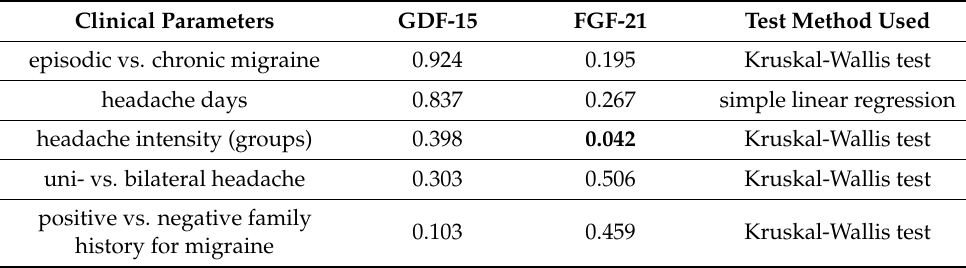
Table 2. Clinical parameters of headache and their impact on GDF-15 and FGF-21 levels. The results are given as p values ( p < 0.05 in bold print). At p values > 0.05, there is no statistically significant association between the respective clinical parameter and the biomarker. Due to different variable types, different statistical tests were used for analysis. Only for increasing headache intensity was a correlation with higher FGF-21 levels